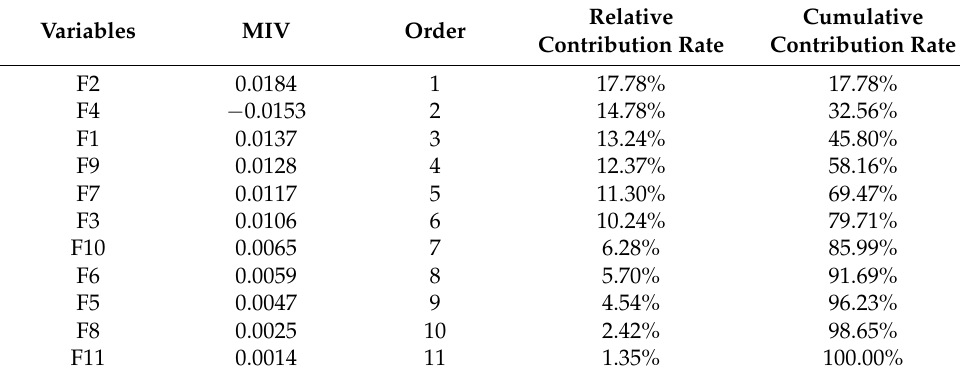
Table 11. Cumulative contribution rate of input